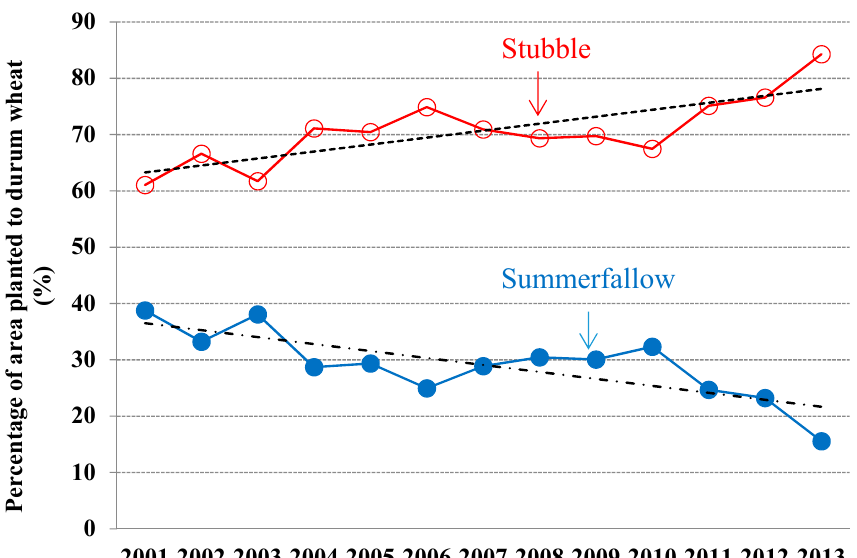
Figure 8. The proportion of Canadian durum crops area grown on summerfallow versus on stubble fields in Saskatchewan from 2001 to 2013 (Source: Saskatchewan Crop Insurance Corporation, n = 361,684 individual durum wheat growers). The relationship between percent stubble area and year was: % stubble area = 0.0124 × year + 0.6 (the top line); the relationship between percent summerfallow and year was: % summerfallow area = − 0.0124 × year + 0.4 (the bottom line).